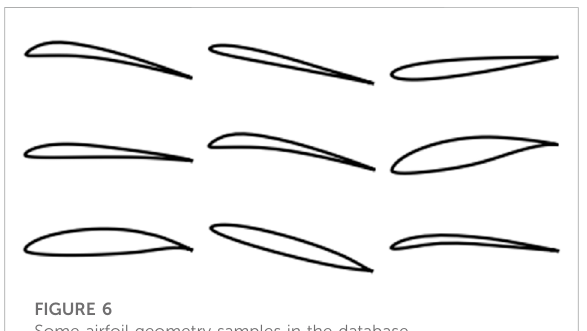
FIGURE 6 Some airfoil geometry samples in the